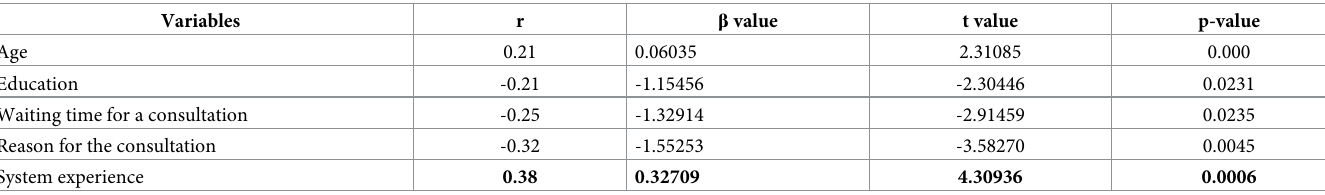
Table 7. Multiple regression analysis